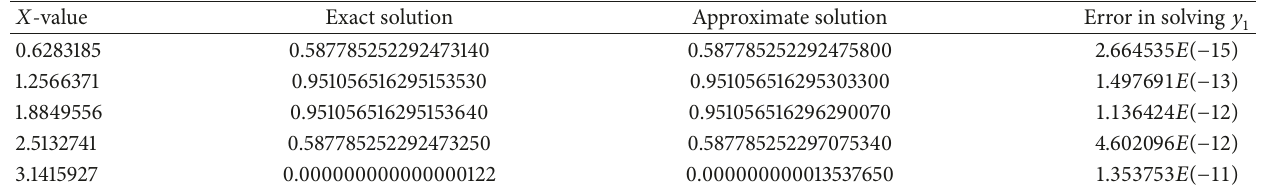
Table 9: Exact and approximate solutions for solving 𝑦 1 using the developed